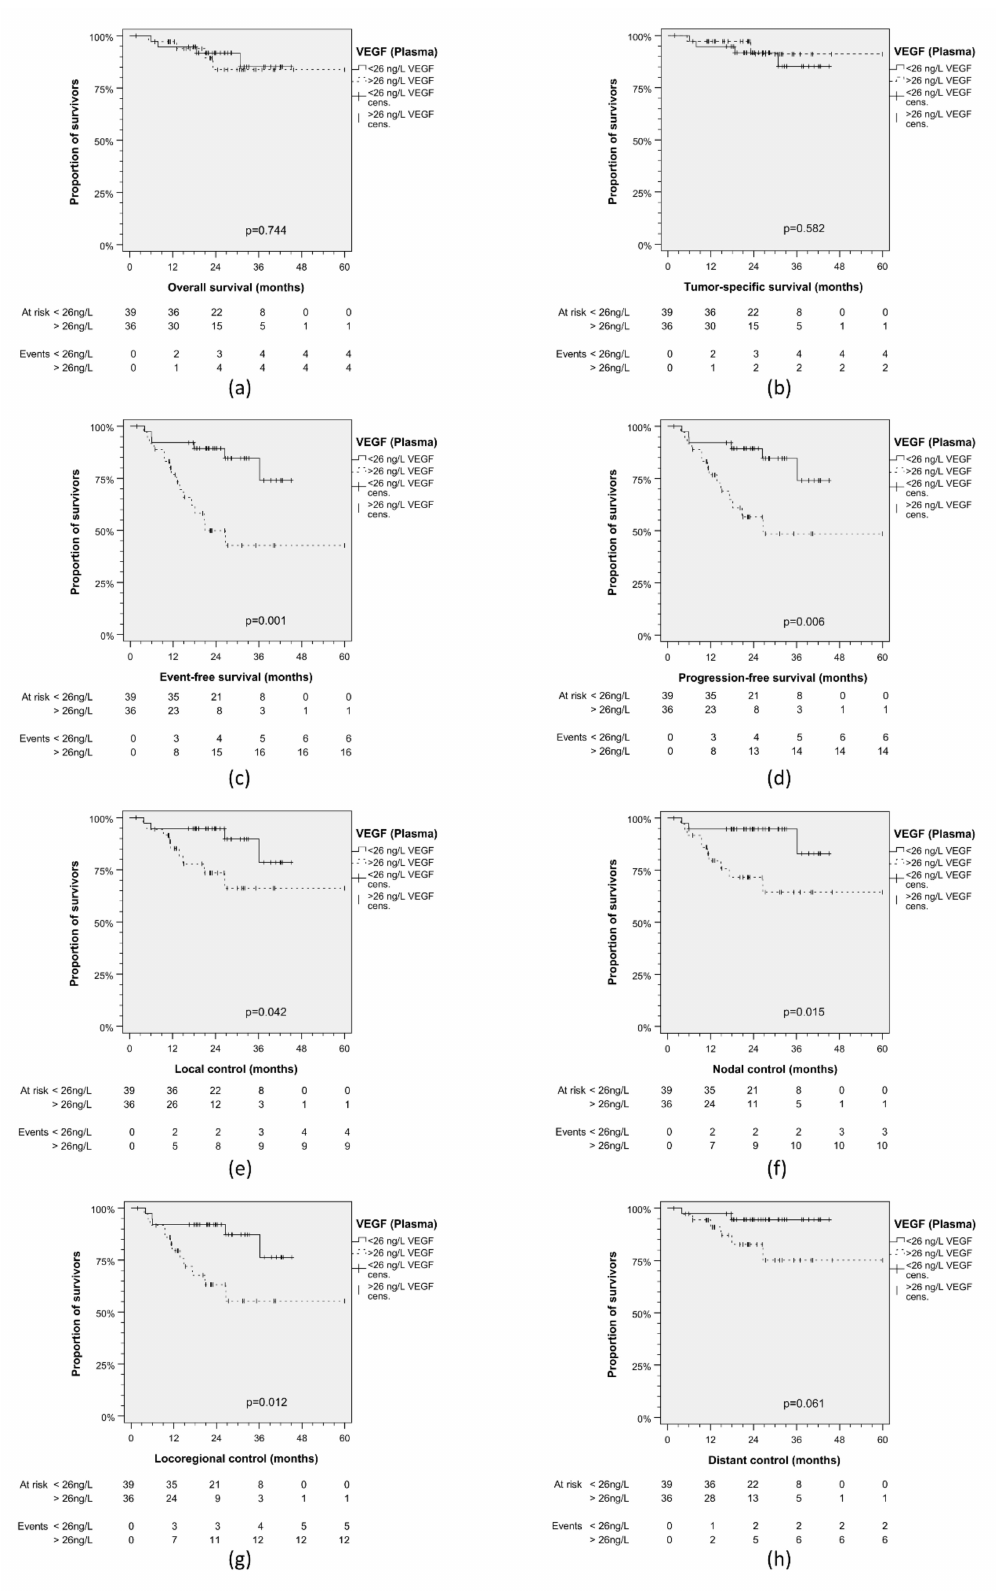
Figure 2. Kaplan–Meier plots for cumulative survival in HNSCC patients from the test cohort stratified according to VEGF in pre-therapeutic plasma. ( a ) Overall survival; ( b ) tumor-specific survival; ( c ) event-free survival; ( d ) progression-free survival; ( e ) local control; ( f ) nodal control; ( g ) loco-regional control; ( h ) distant control. p values shown are from 2-sided log-rank